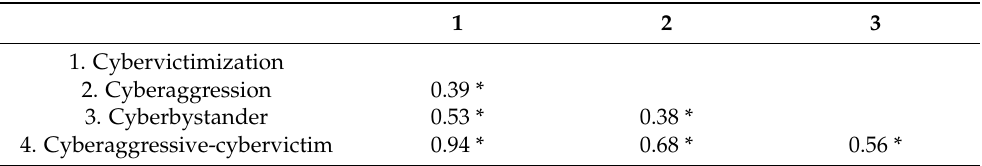
Table 2. Bivariate partial correlation, controlling for effect of sex and age on the total indexes of the four roles.